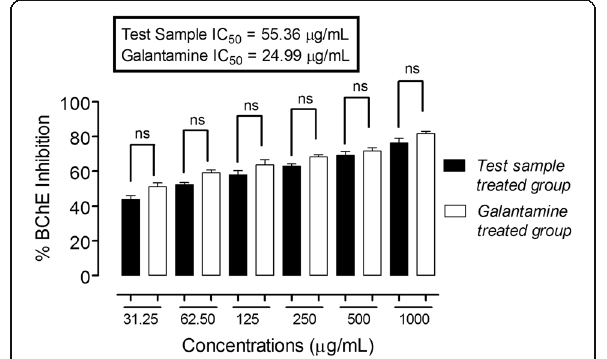
Fig. 8 Butyrylcholinesterase inhibitory activity (BChE) of aqueous methanolic extract of Olax nana using Ellmen's assay. One-way ANOVA followed by Bonferroni ’ s multiple comparison post hoc test was used for statistical significant different between the standard drug (galantamine) and test sample at the same concentration, at 95% confidence interval. ns: values not significantly different in comparison to % inhibition of the standard drug ( P >0.05) at the same